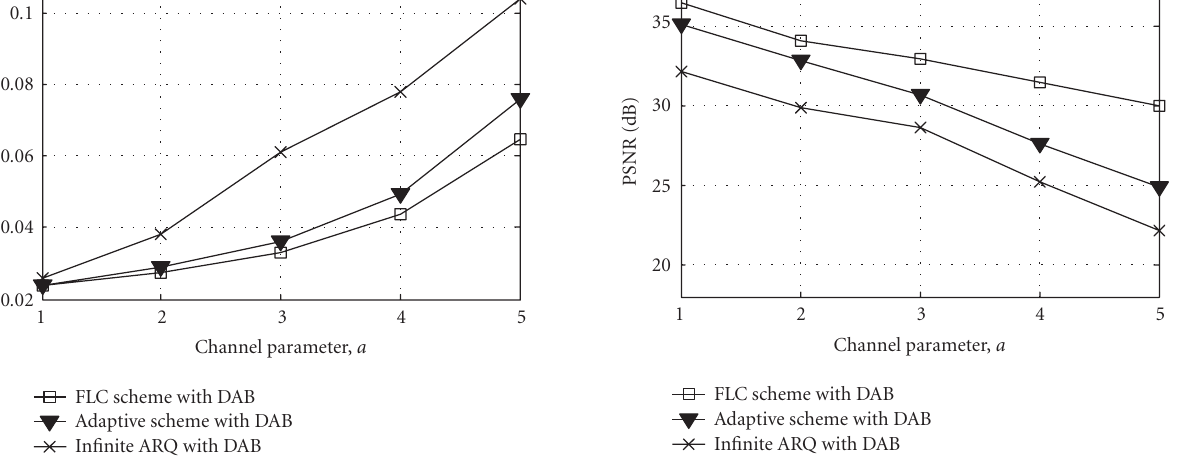
Figure 6: Mean packet delay ARQ with DAB scheme, according to channel conditions.